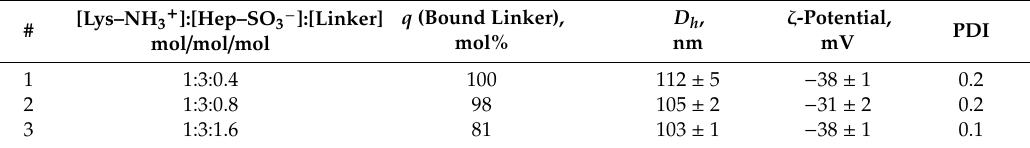
Table 1. Characteristics of IPECs obtained with application of photosensitive linker. The complex of PLL with oligo-dT-dA was formed prior to addition of Hep. [Lys–NH 3 + ]:[olig-dT-dA-PO 4 − ] ratio was 1:0.5 in all